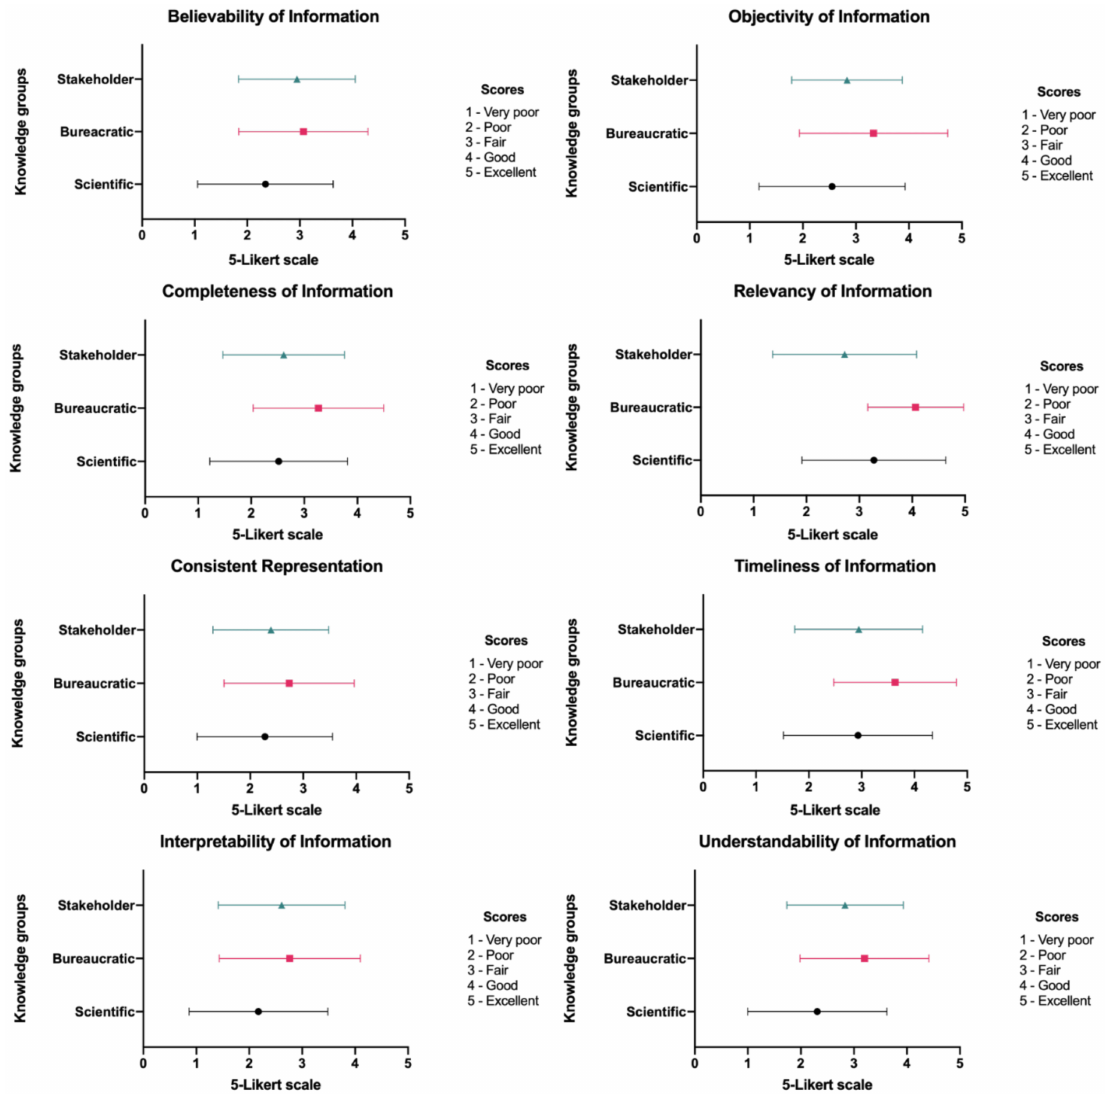
Figure 2. An arithmetic average of a range of values estimated. The horizontal bar plot shows minimum, mean, and maximum values of information quality within groups. The dependent variable consists of five values (very poor/poor/fair/good/excellent) on a 5-point Likert scale. The independent variables are scientific, bureaucratic, and stakeholders’